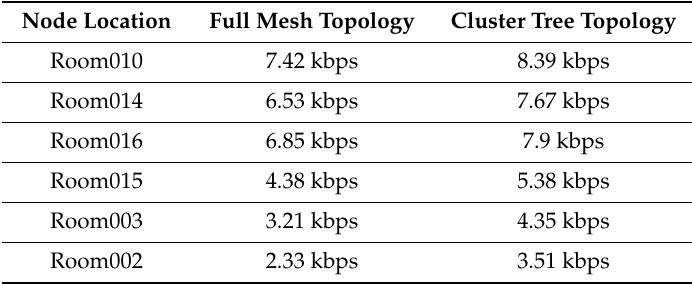
Table 5. Throughput test of sensor nodes in di ff erent topologies.